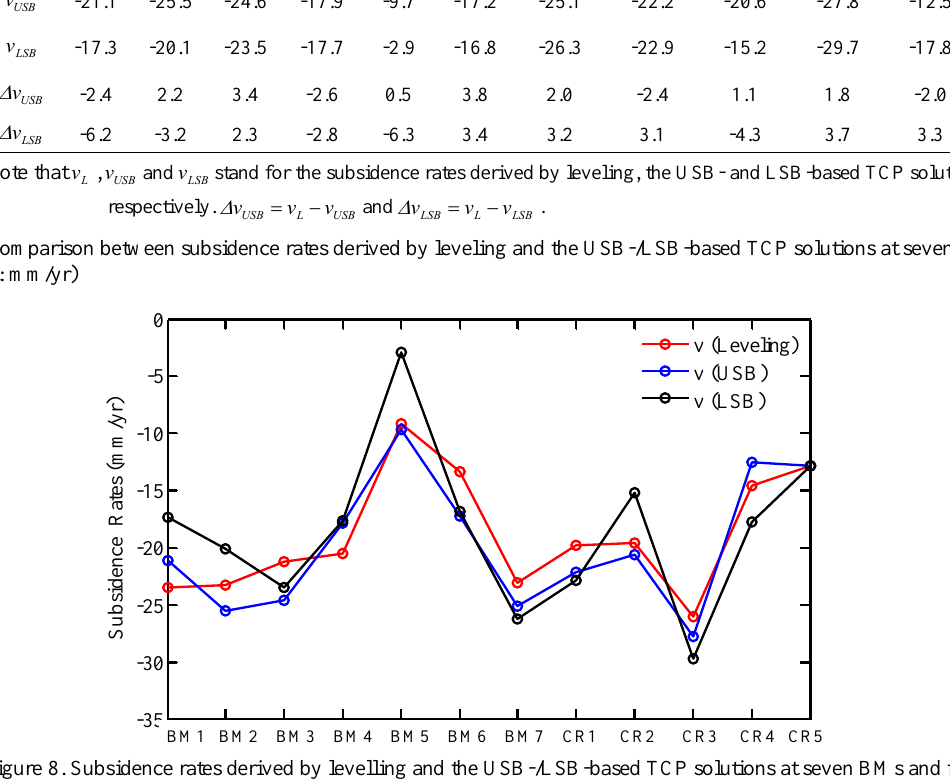
Figure 8. Subsidence rates derived by levelling and the USB-/LSB-based TCP solutions at seven BMs and five